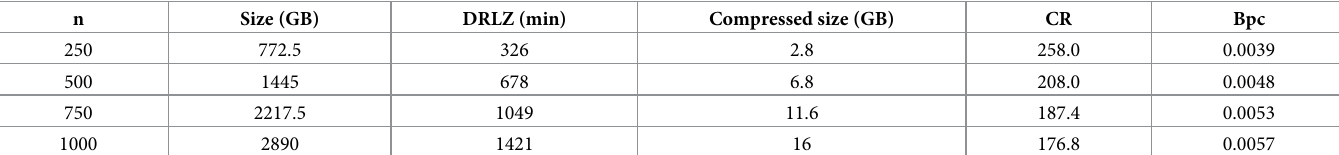
Table 2. Compressing human pan-genomes using reference sequence size of 30%. n